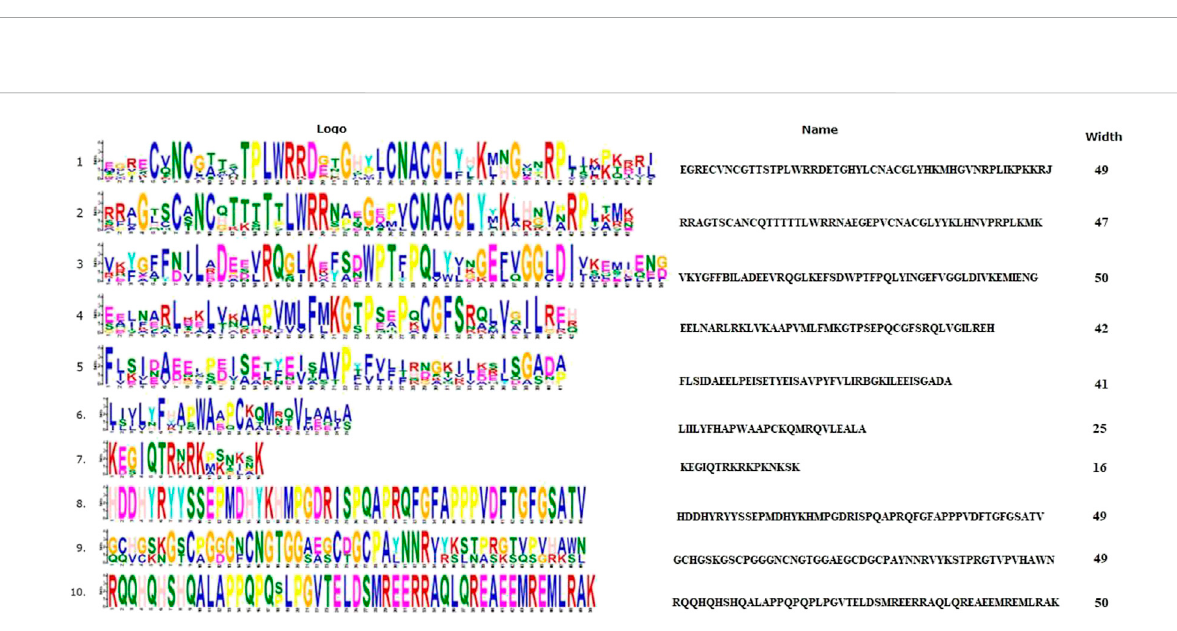
FIGURE 5 The 10 conserved motifs of selected proteins in Figure 1. The sequence logos was created by the MEME Suite.